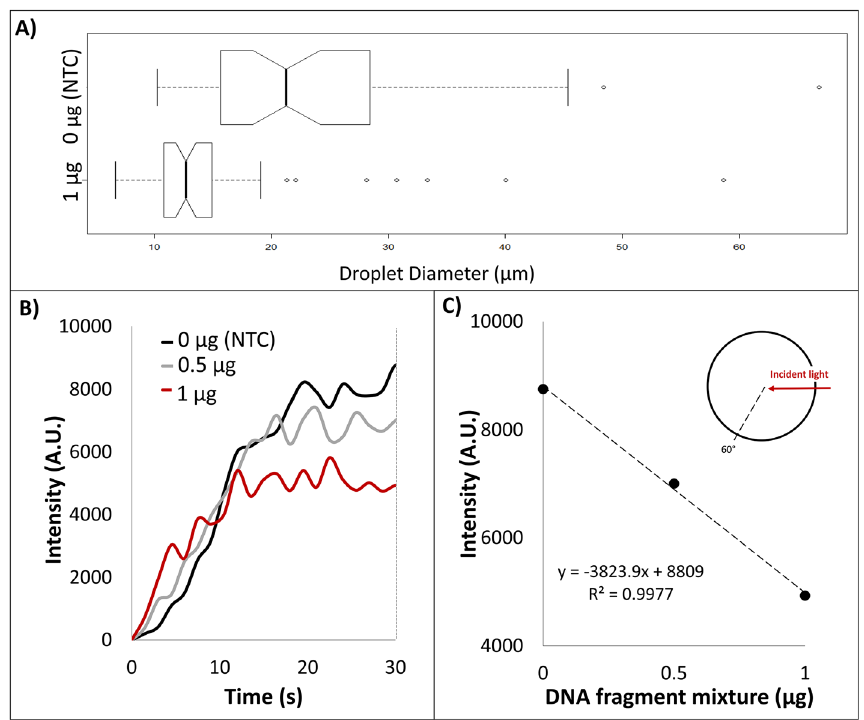
Figure 2. ( A ) Measured diameter from light microscope images of water–oil emulsions containing 10 µL of aqueous 1 and 0 µg DNA fragment mixture. ( B ) Emulsion light scatter intensity at 60° with respect to 650 nm incident light over time of 1, 0.5, and 0 µg DNA fragment mixture in 10 µL aqueous phase. ( C ) The 60° intensities at 30 s plotted against the DNA fragment